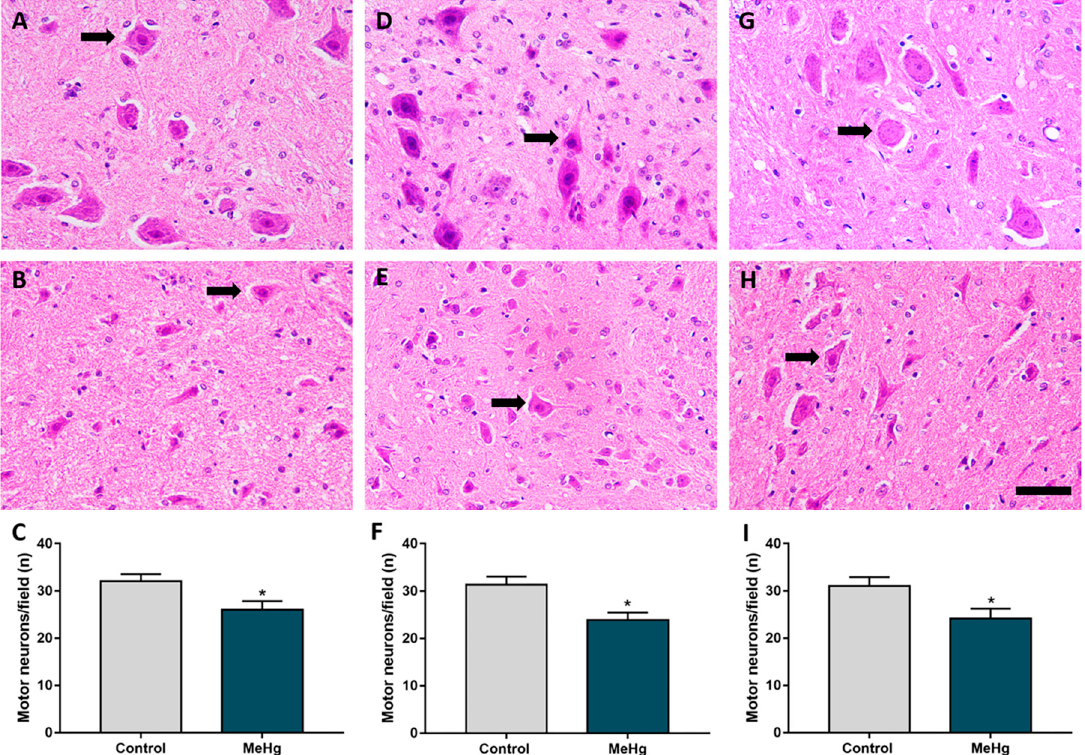
Figure 2. MeHg caused a reduction in the density of motoneurons in all areas evaluated. Effect of MeHg on the cervical ( A – C ), thoracic ( D – F ) and lumbar ( G – I ) segments of the spinal cord in the offspring rats ( n = 7 animals per group) after exposure during the intrauterine and lactation periods to 40 μ g/kg/day of MeHg (samples collected 21 days after 42 days of dosing). ( A , D , G ) are representative photomicrographs of the motoneuron counts in the control group and ( B , E , H ) in the exposed group. In ( C , F , I ) are the results of the motoneuron density, expressed as the mean ± standard error of the mean ( n = 7–8 animals per group). * p < 0.05, Student’s t -test. Black arrows indicate motoneurons. Scale bar: 20 μ m.